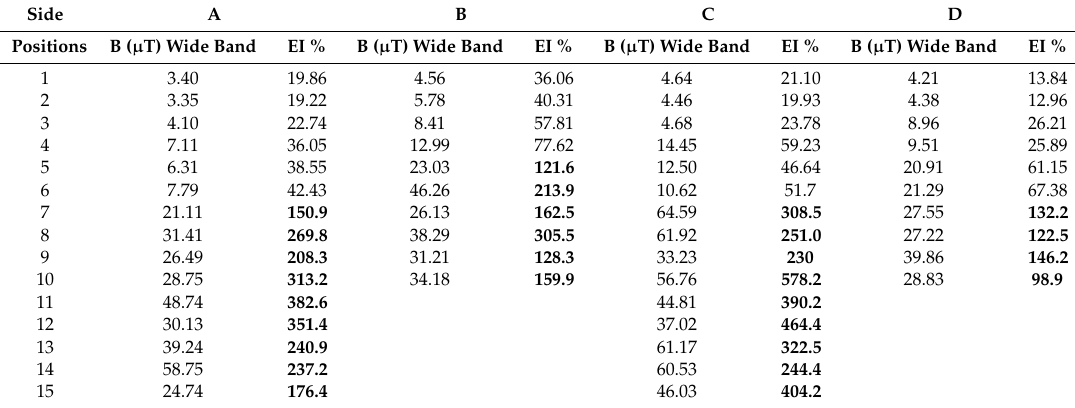
Table 2. B-field and exposure indexes (EIs) according to the measurement grid for the power unit slave, HPCS 1.